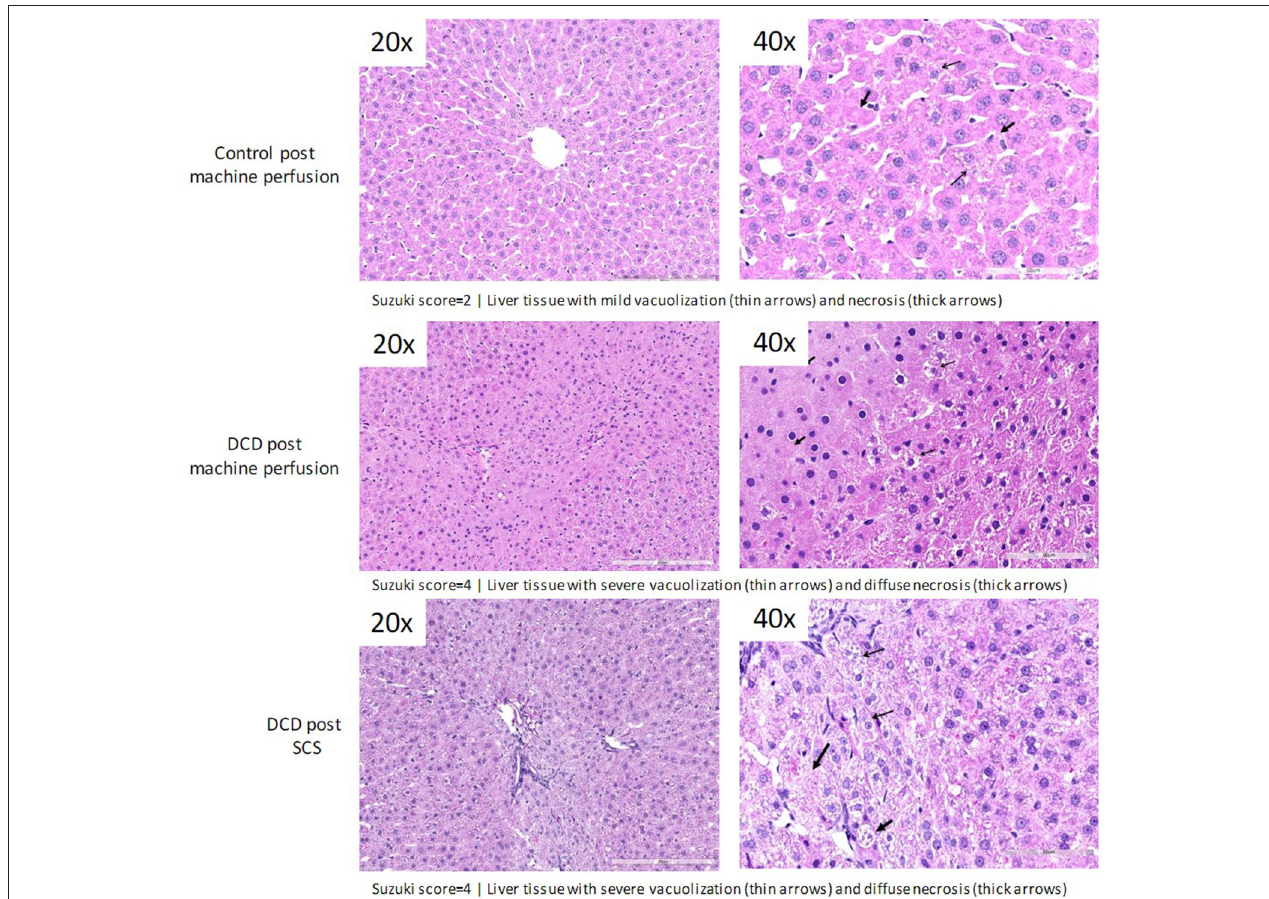
FIGURE 6 | Higher magnification of graft histologic injury by Suzuki score following preservation by SCS vs. acRTMP.